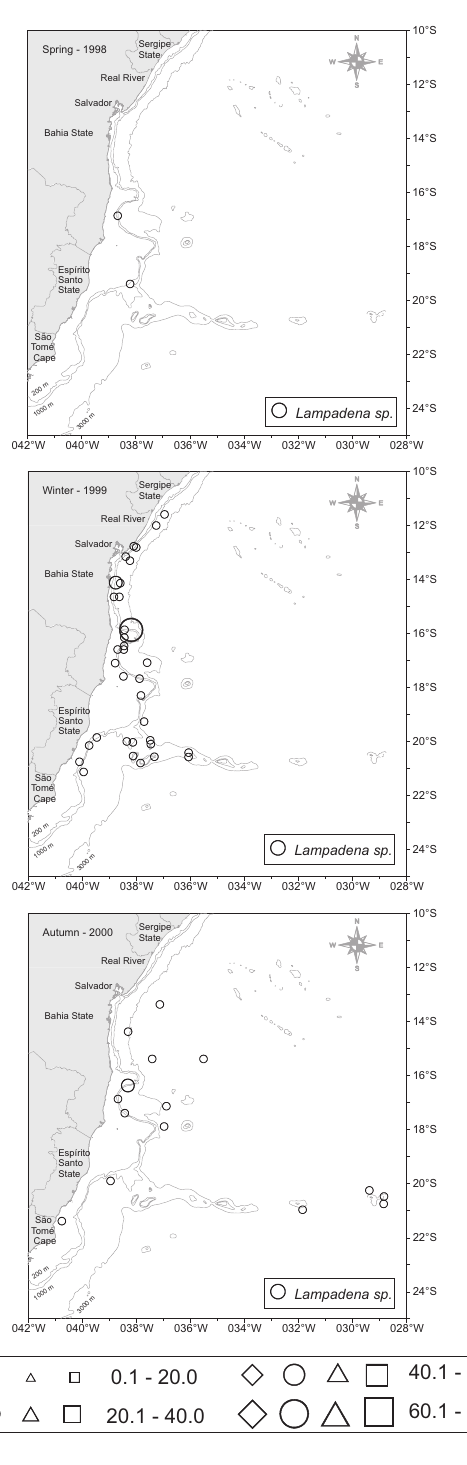
Figure 12. Density (larvae under 10 m -2 of sea surface) distribution of the most abundant myctophid species: Lampadena sp. (12).